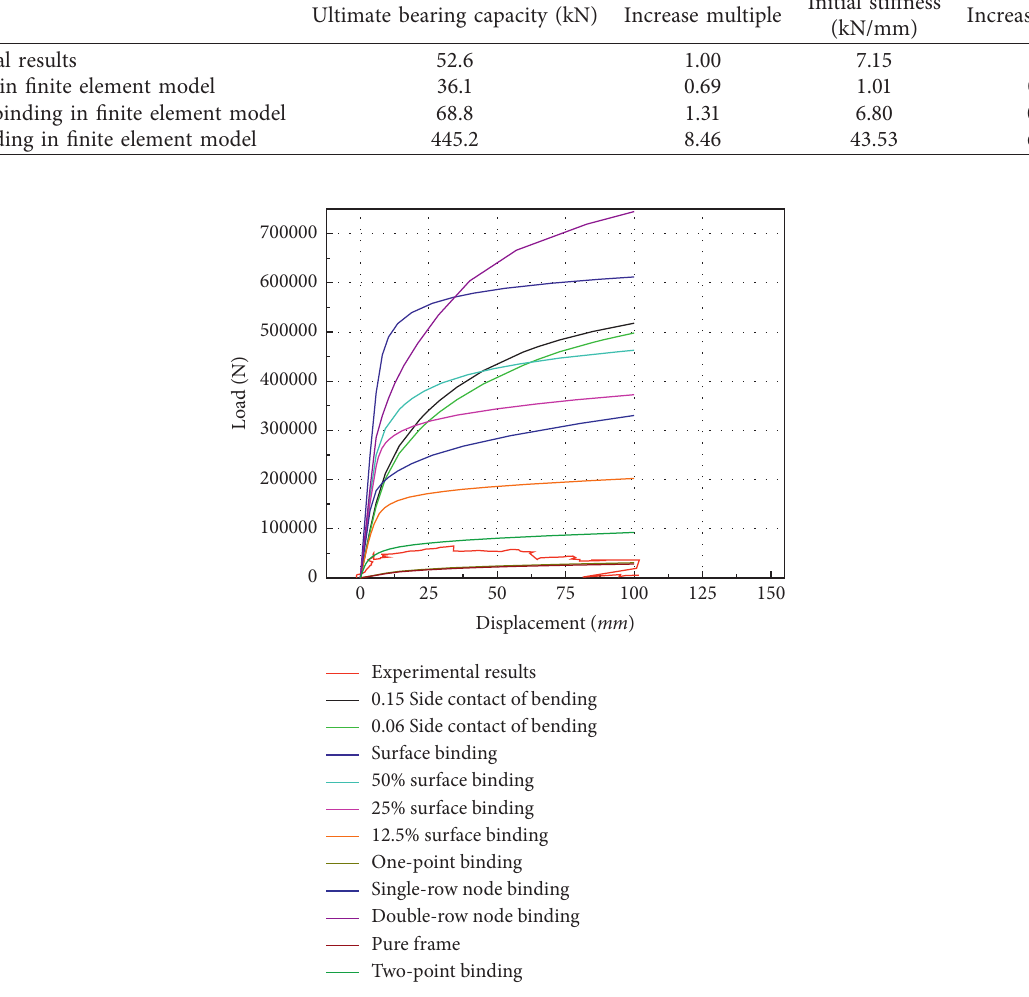
Figure 19: Comparison of load-displacement curve for